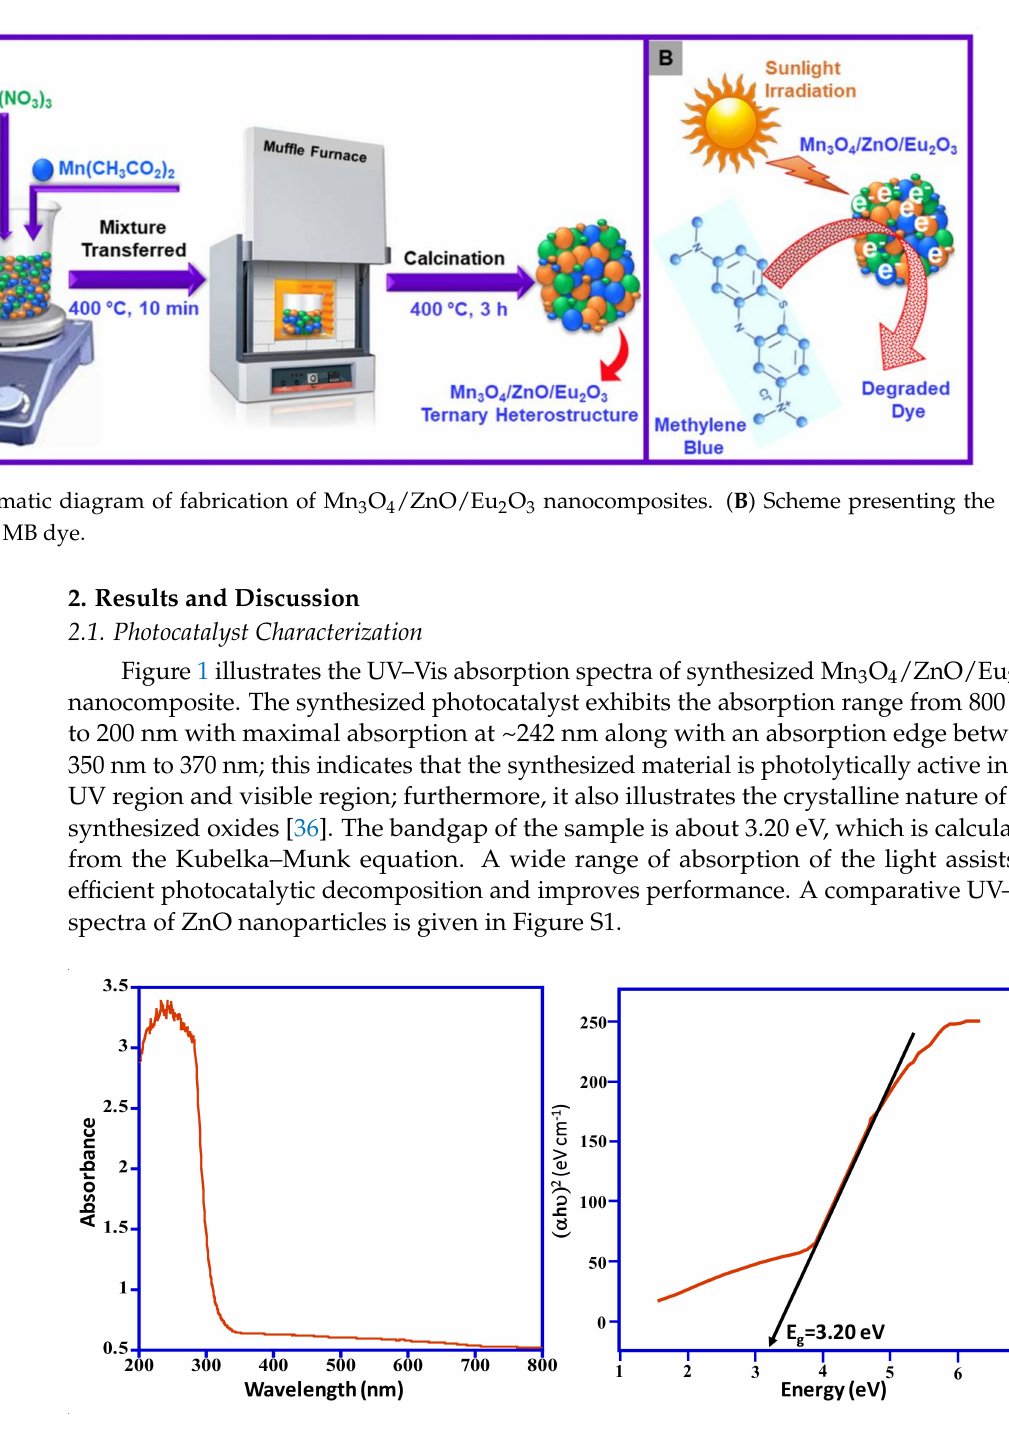
Figure 1. UV–Vis absorption and bandgap spectrum of the fabricated Mn 3 O 4 /ZnO/Eu 2 O 3